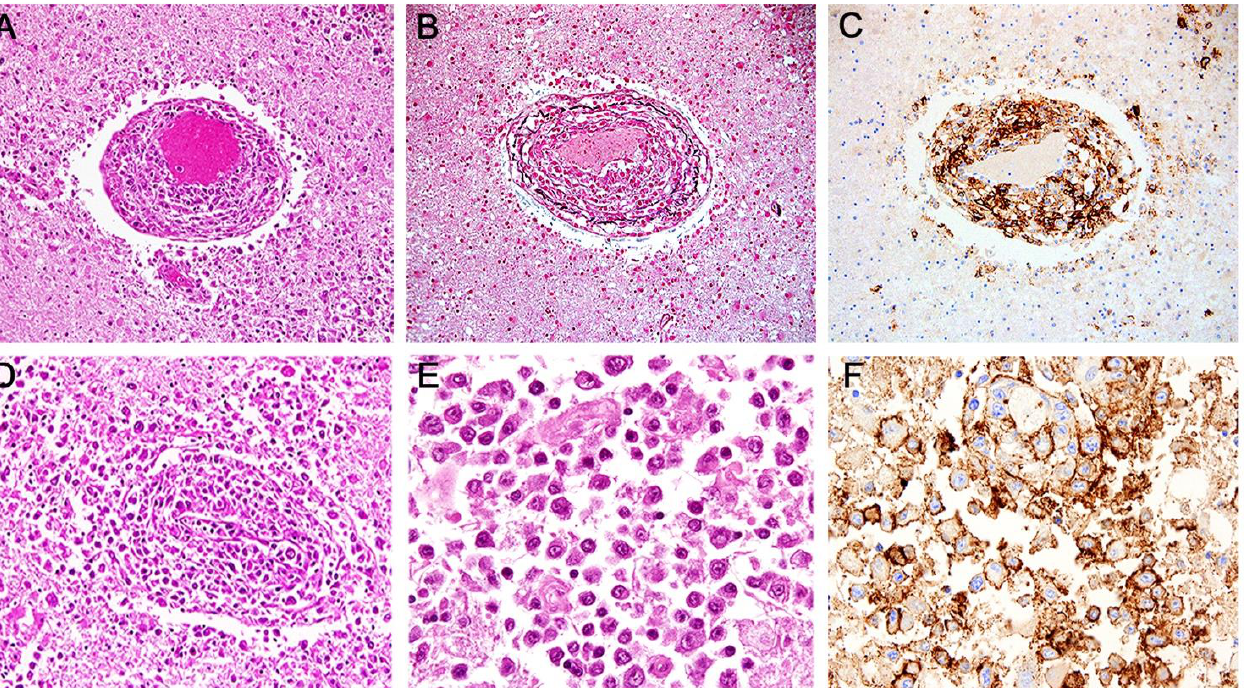
Figure 2. Histological and immunohistochemical profile of the tumor: Microscopically, the tumor is composed by numerous sheets of neoplastic cells, which in the periphery of the tumor are confined to the Virchow – Robin space (Panel ( A ), H&E), layered within reticulin fibers (Panel ( B ), reticulin), and in more central areas, break and invade into the brain parenchyma (Panel ( D ), H&E). At higher magnification, the neoplastic cells are round, with some degree of nuclear pleomorphism and scant cytoplasm (Panel ( E ), H&E). Immunohistochemically, the neoplastic cells express CD-20 (Panel ( C )), and CD-79b (Panel ( F )), confirming their B-cell